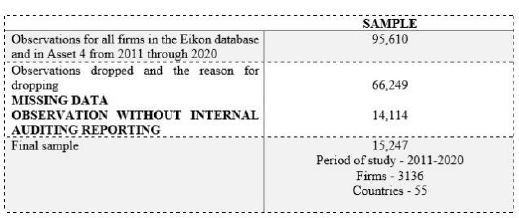
Table 1a: Sample Selection